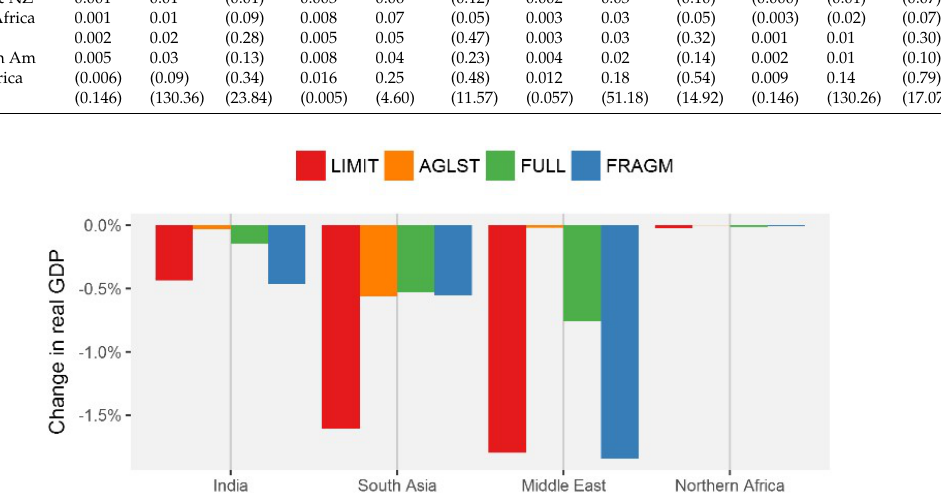
Figure 4. Real GDP impacts by region and by allocation method.